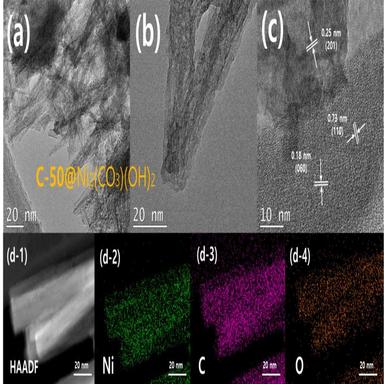
(a) and (b) Low-magnification TEM images; (c) HRTEM image of the C-50@Ni2(CO3)(OH)2 compound; (d) EDS elemental mapping of the optimized C-50@Ni2(CO3)(OH)2 compound with the HAADF image and EDS mapping of Ni, C, and O.